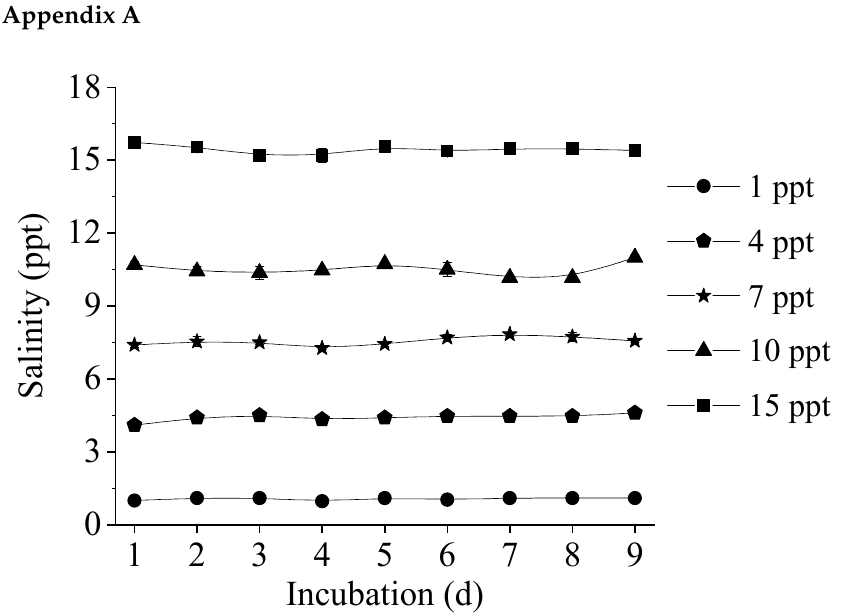
Figure A1. Variation in salinity during the study.